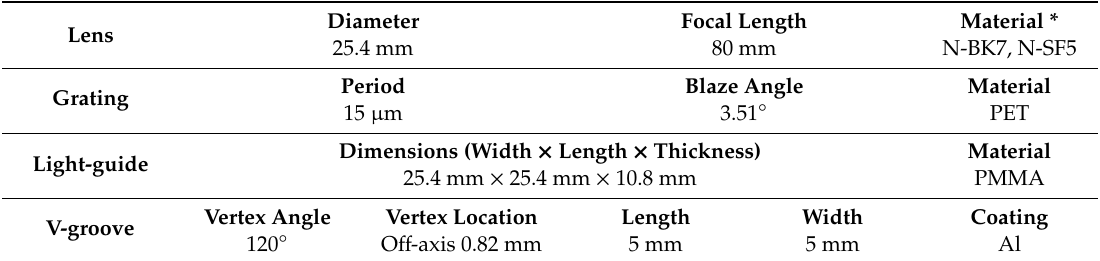
Table 1. Designed parameters of the components for each unit in the 7-unit module.